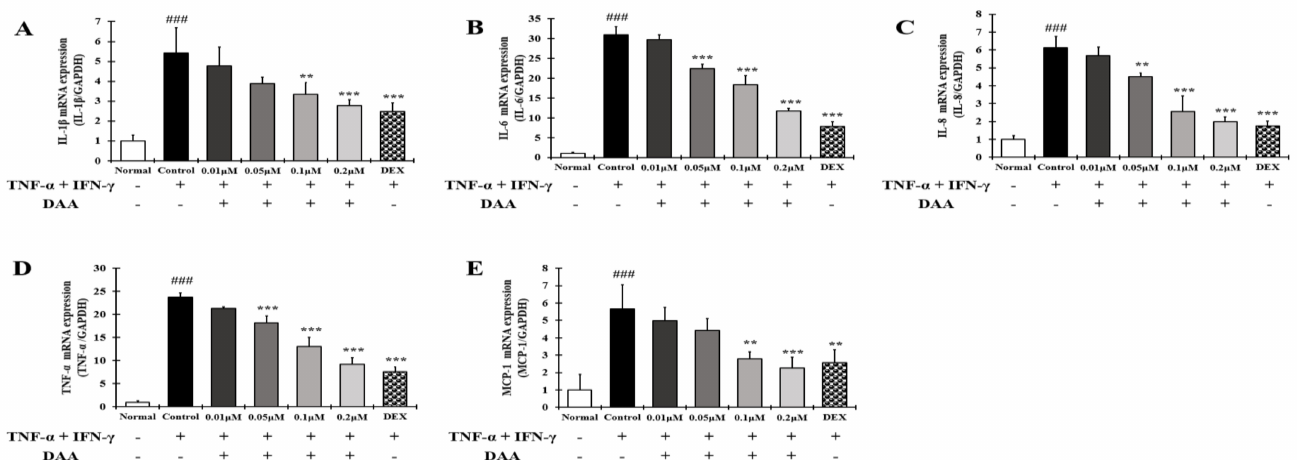
Figure 6. Effect of DAA on the gene expression levels of AD-related cytokines and chemokines in HaCaT cells. The gene expression levels of IL-1 β ( A ), IL-6 ( B ), IL-8 ( C ), TNF- α ( D ), and MCP-1 ( E ) are shown. Total RNA was isolated from HaCaT cells and analyzed by RT-qPCR. The expression levels were then normalized to those of GAPDH. The results are expressed as the mean ± SD (n = 4). ### p < 0.001 vs. normal; ** p < 0.01 and *** p < 0.001 vs. control; DAA was used at 0.01 µ M, 0.05 µ M, 0.1 µ M, and 0.2 µ M. DEX, the positive control, was used at 0.1 µ M.